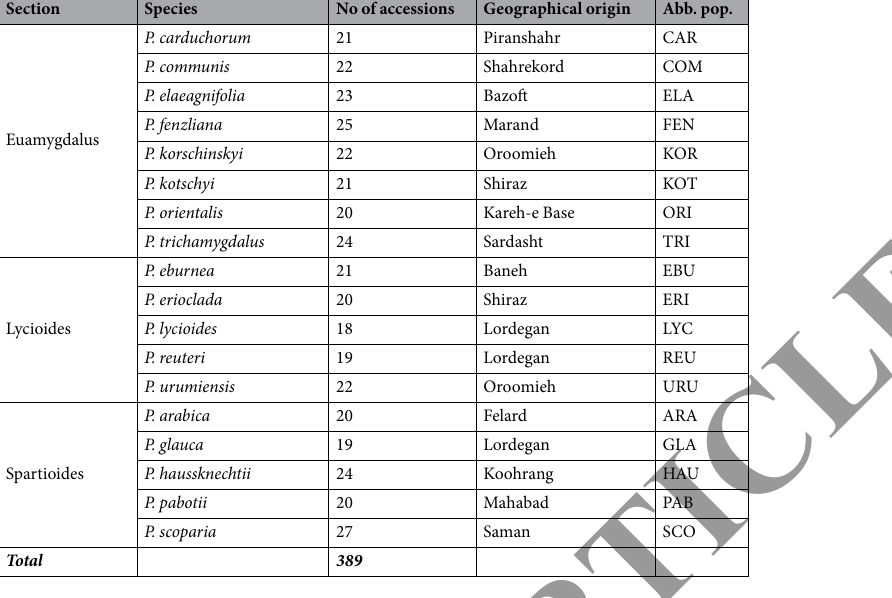
Table 1. Wild almond species populations used in this study, and their